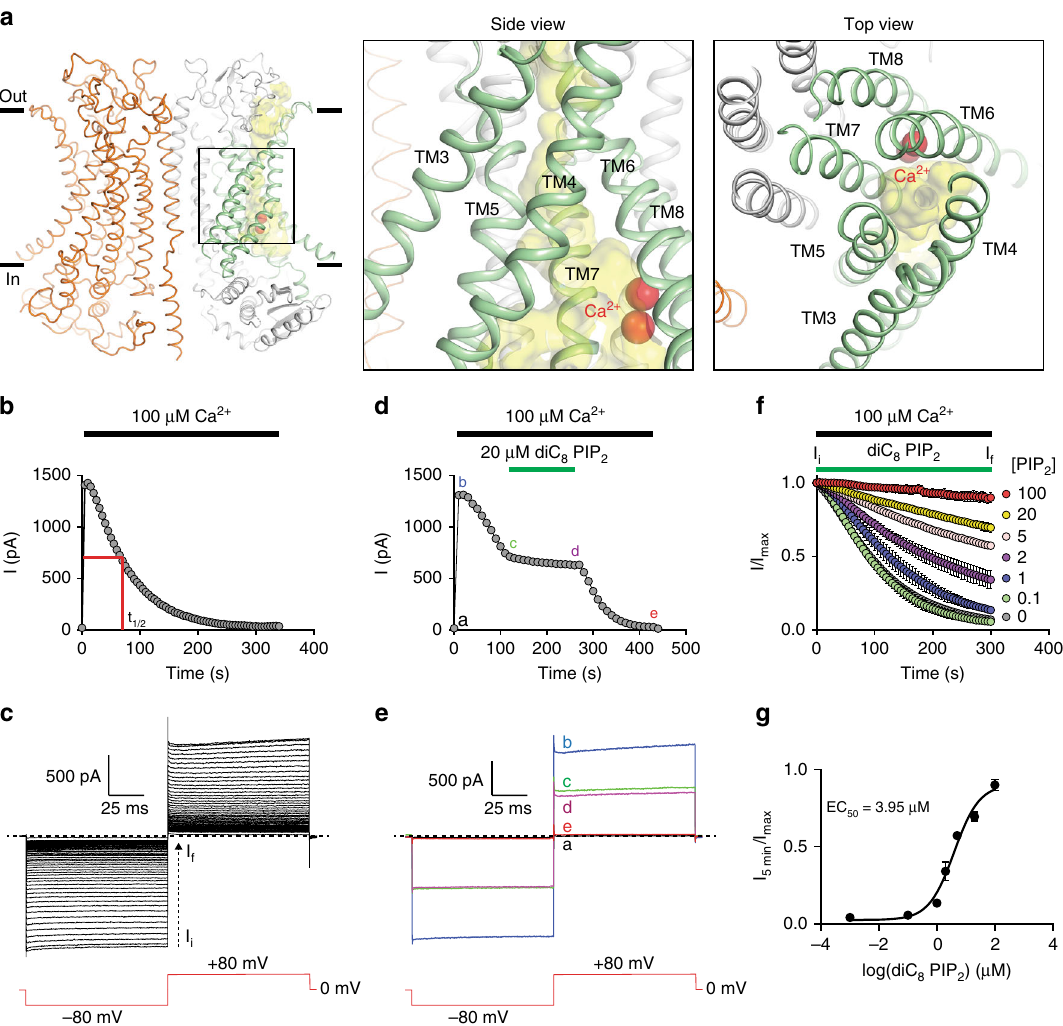
Fig. 1 PIP 2 attenuates TMEM16A desensitization in saturating Ca 2 + . a Overall architecture of the homodimeric Ca 2 + -bound mouse TMEM16A with two monomers colored in orange and gray, respectively (PDB 5OYB). The yellow surface depicts the solvent-accessible volume of the putative permeation pore, which is in an apparently nonconductive state despite Ca 2 + binding (red spheres). Green helices encompass the permeation pathway. b , c Representative recording showing TMEM16A channel activity recorded using inside-out patch clamp under saturating 100 µ M intracellular Ca 2 + (black bar). Currents were elicited by the voltage protocol shown in inset at a 5-s interval. t 1/2 denotes the half decay time (see “ Methods ” ); n = 23 independent recordings. d , e Representative recording of TMEM16A under saturating 100 µ M intracellular Ca 2 + (black bar) in the presence or absence of 20 µ M diC 8 PIP 2 (green bar). Representative current traces at different time points in d are shown in e ; n = 8 independent recordings. f diC 8 PIP 2 attenuates TMEM16A channel desensitization in a dose-dependent manner. I i and I f are the initial and fi nal current amplitudes during the 5-min application of Ca 2 + . g Dose-dependence of diC 8 PIP 2 in retaining TMEM16A channel activity. The sigmoidal curve represents fi t to the Hill equation. The half-maximal concentration (EC 50 ) for diC 8 PIP 2 is 3.95 µ M. n = 4 to 8 for each diC 8 PIP 2 concentration. Data are mean ±s.e.m. Source data are provided as a Source Data fi